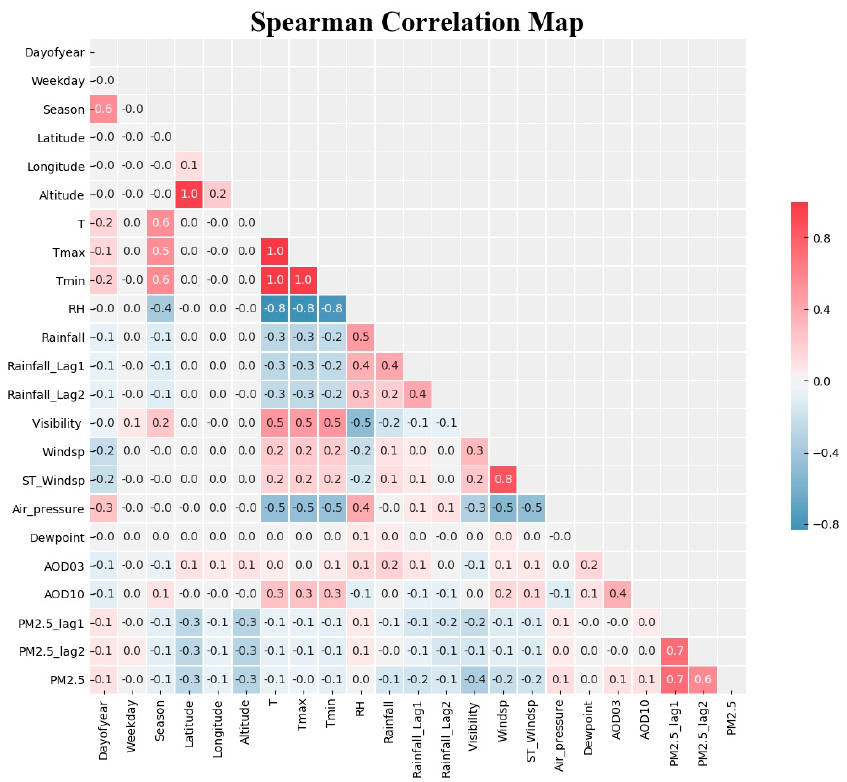
Figure 9. Spearman’s correlation coe ffi cient heat map for the study variables shown above. Positive Figure 9. Spearman ʹ s correlation coefficient heat map for the study variables shown above. Positive correlations are marked by red while negative correlations are marked by correlations are marked by red while negative correlations are marked by blue.